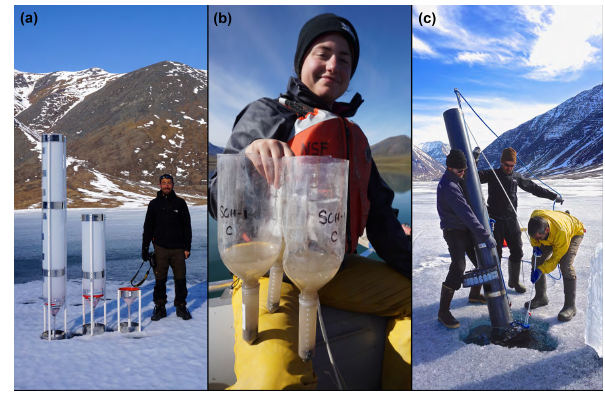
Figure 9. Examples of the types of sediment traps installed in Lake Peters: (a) static traps used to investigate the effect of collection- tube aspect ratio, (b) 2L bottle static traps upon retrieval, and (c) in- stallation of an incrementing